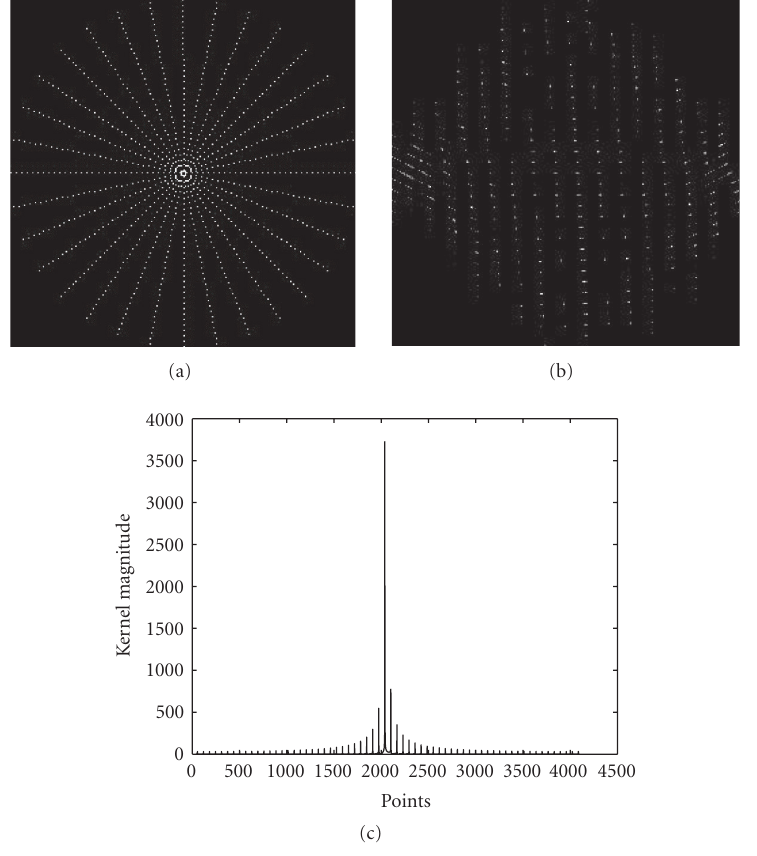
Figure 2: Illustration of the energy compacting transformation: (a) example polar trajectory, (b) the constructed system matrix after the energy compacting transformation with only a few nonzero elements, (c) sample row showing only few nonzero peaks.